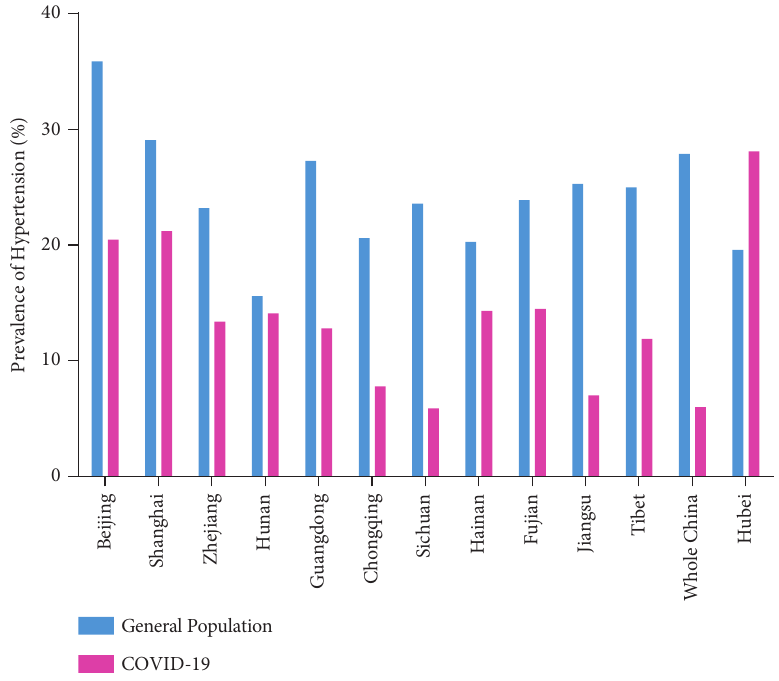
Figure 3: Comparison of the incidence rates of hypertension in COVID-19 patients with that from the China Hypertension Survey, 2012–2015, in 11 provinces and all of